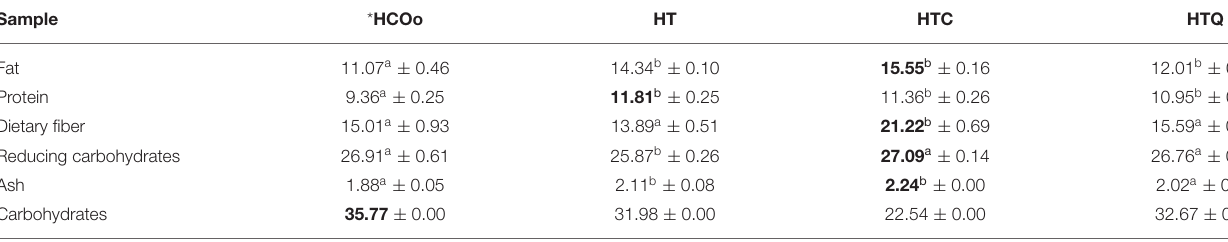
TABLE 1 | Results of the proximate chemical analyses of the ice cream upon a dry basis (g/100g of sample).